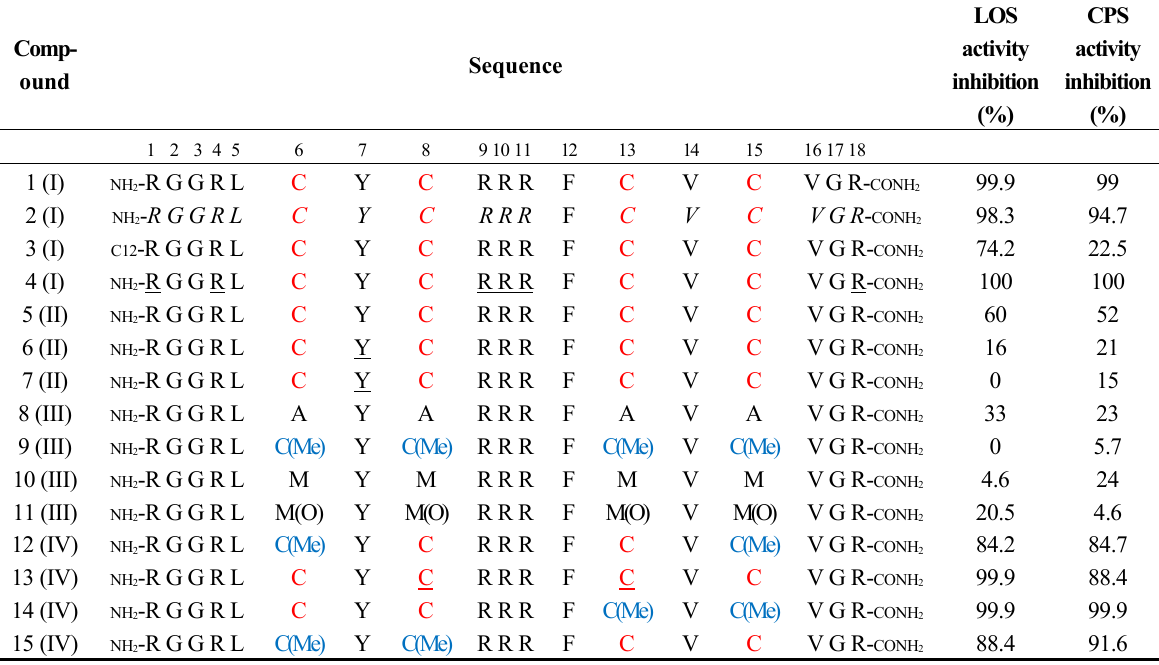
Table 1. PG-1 and its analogs used in this study and their